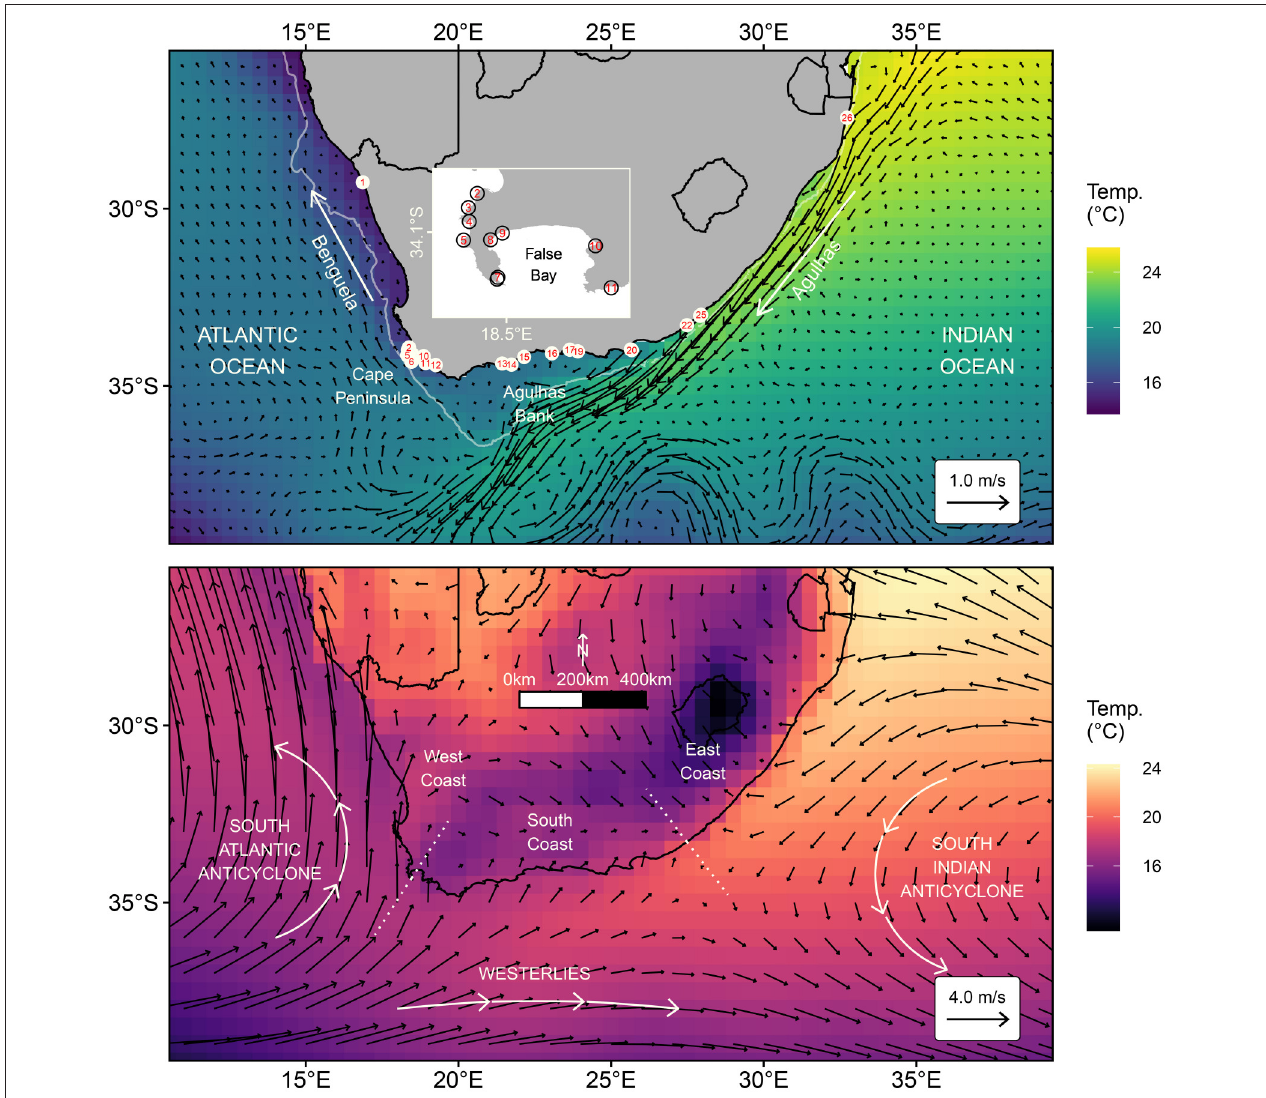
FIGURE 1 | Map of the study area where the top panel shows the mean annual sea surface temperature (SST) and surface currents from 1993 to 2016, as well as the locations referred to in the text. The sites of in situ collection are shown with red numerals over white circles. An inset map of the Cape Peninsula/False Bay area is shown where site labels are obscured due to overplotting. The bottom panel shows the mean surface atmospheric temperature and winds, and highlights the three coastal sections found within the study area as well as the three predominant wind patterns. Note that the temperature and vector scales differ between the two panels. The white vector arrows showing the predominant ocean and atmosphere circulation patterns are approximations and not exact